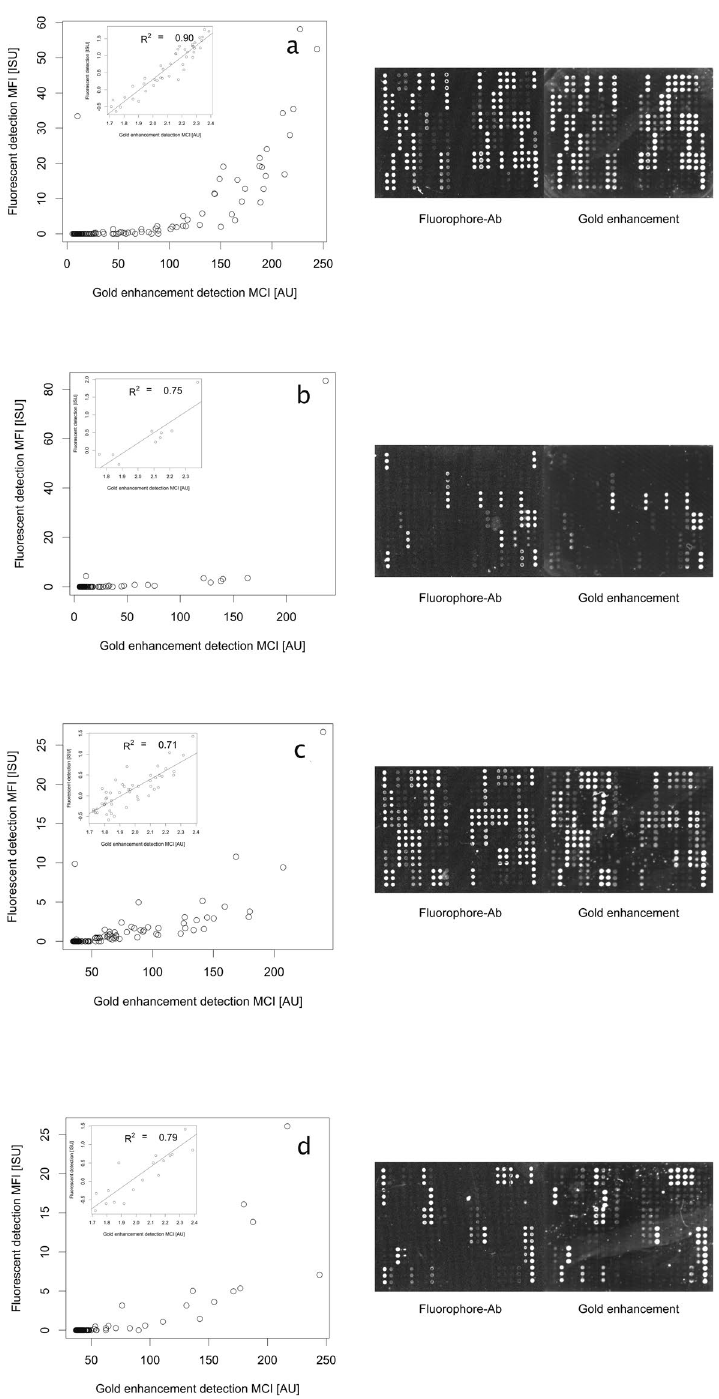
Figure 3. Comparison of mean fluorescent intensity (MFI) obtained with fluorescence detection and mean colorimetric intensity (MCI) obtained with gold enhancement detection for samples ( a , b , c and d ). Insets display the same data log 10 transformed in the interval where there is a linear correlation between the two methods. For each sample, the arrays were scanned for further data analysis. In the fluorescence-based detection, the brightness of spots is fluorescence emission, whereas in the gold enhancement-based detection, the image has been inverted and increased brightness indicates a colourimetrically darker spot. Allergens are deposited in vertical triplicates with positive controls for fluorescent detection on the far-right bottom (the remainder three corners are used for software evaluation). Images processed in 16-bit grayscale, the range of intensity levels are